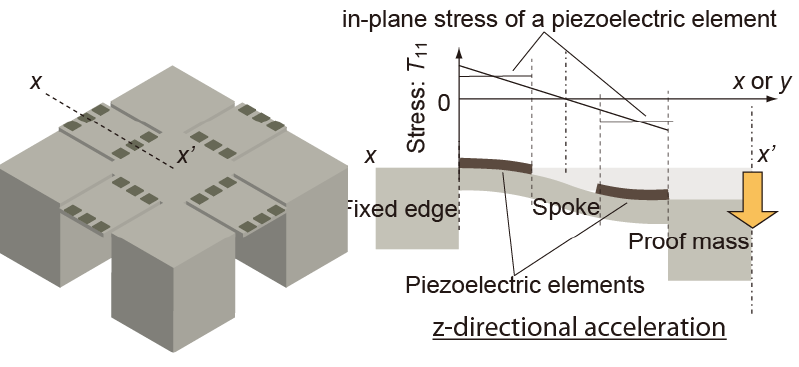
Figure 9. Tri-axis accelerometer using series-connected piezoelectric elements. The stress directions applied to the elements differ from each